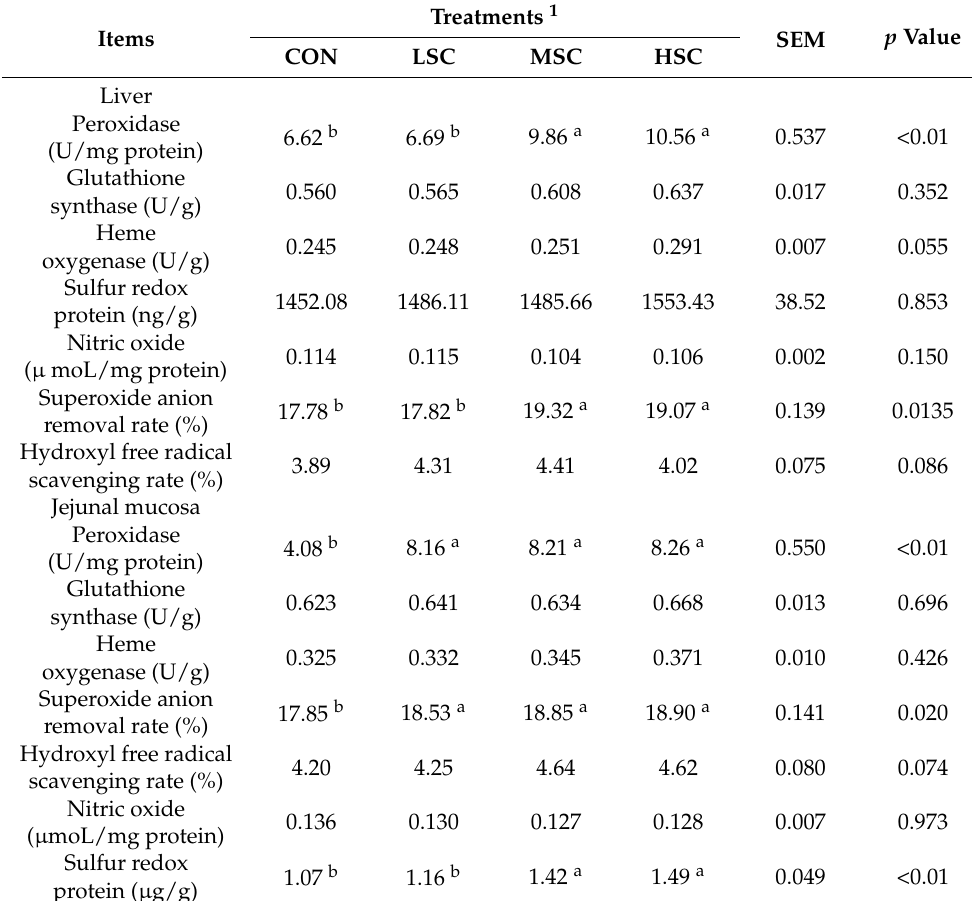
Table 6. Effects of yeast iron on the antioxidant function of liver and jejunal mucosa antioxidant function in weaned